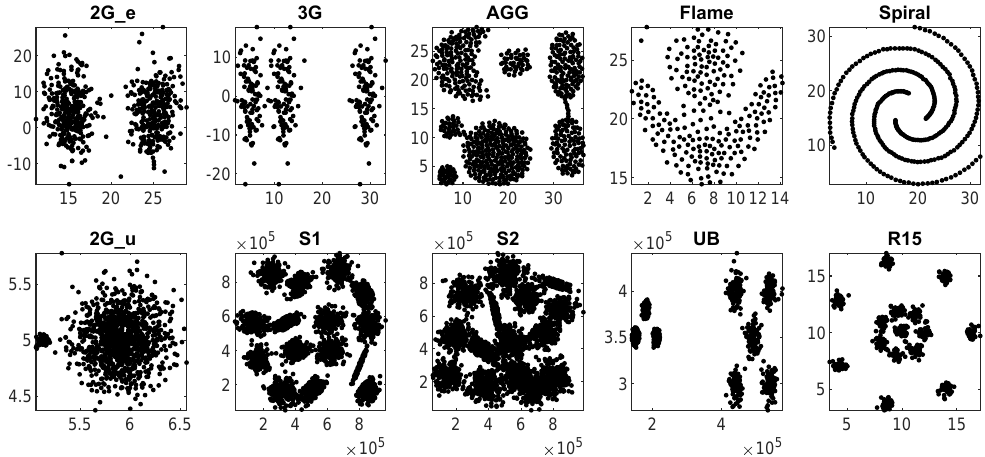
Figure 5. Visualization of the 2-dimensional synthetic datasets. Compared methods. Since the proposed method simultaneously belongs to the cate- gories such as physically-inspired clustering, density-based clustering, and hierarchical clustering, we selected the most relevant methods from these classes. Since the proposed method requires the cluster number as a priori information, all the compared methods can make use of the cluster number as well. What is more, to maximally reduce the influence of the parameter setting, the compared methods either have no parameter or have the suggested empirical settings for the contained parameters. The details of the compared methods are introduced as